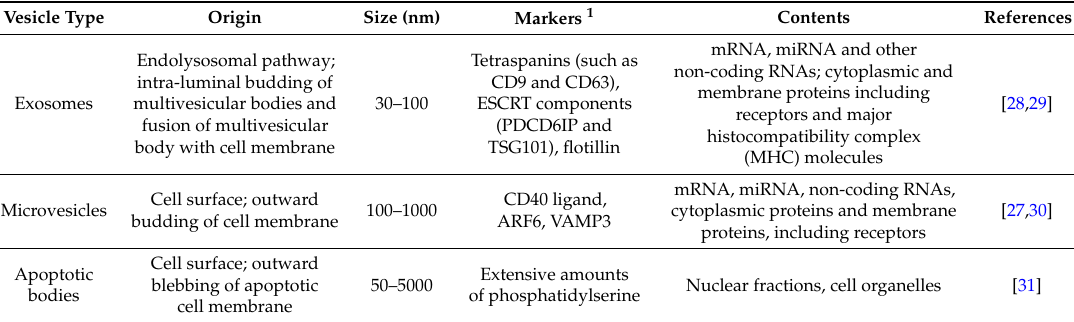
Table 1. Characteristics of the extracellular